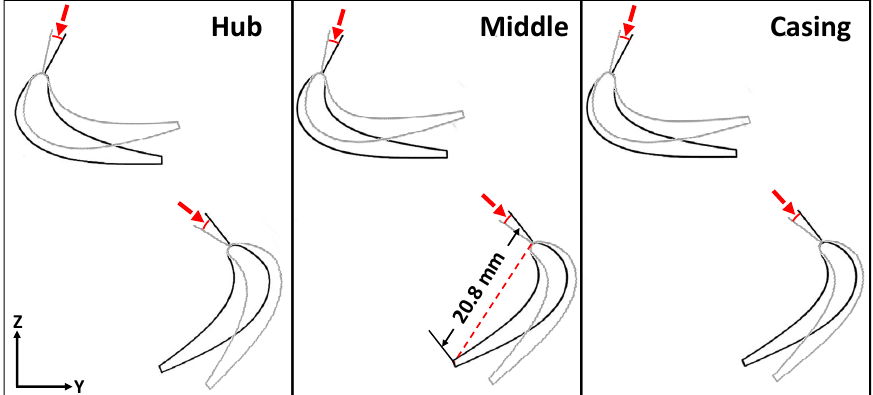
Figure 1. Stator and rotor airfoil profiles at different blade heights and their baseline (0 ◦ ) and articulated positions. Baseline positions are colored in black and articulated positions are colored in gray. The articulation angle is shown by the red arc and highlighted using the red arrow. A positive angle corresponds to a counterclockwise